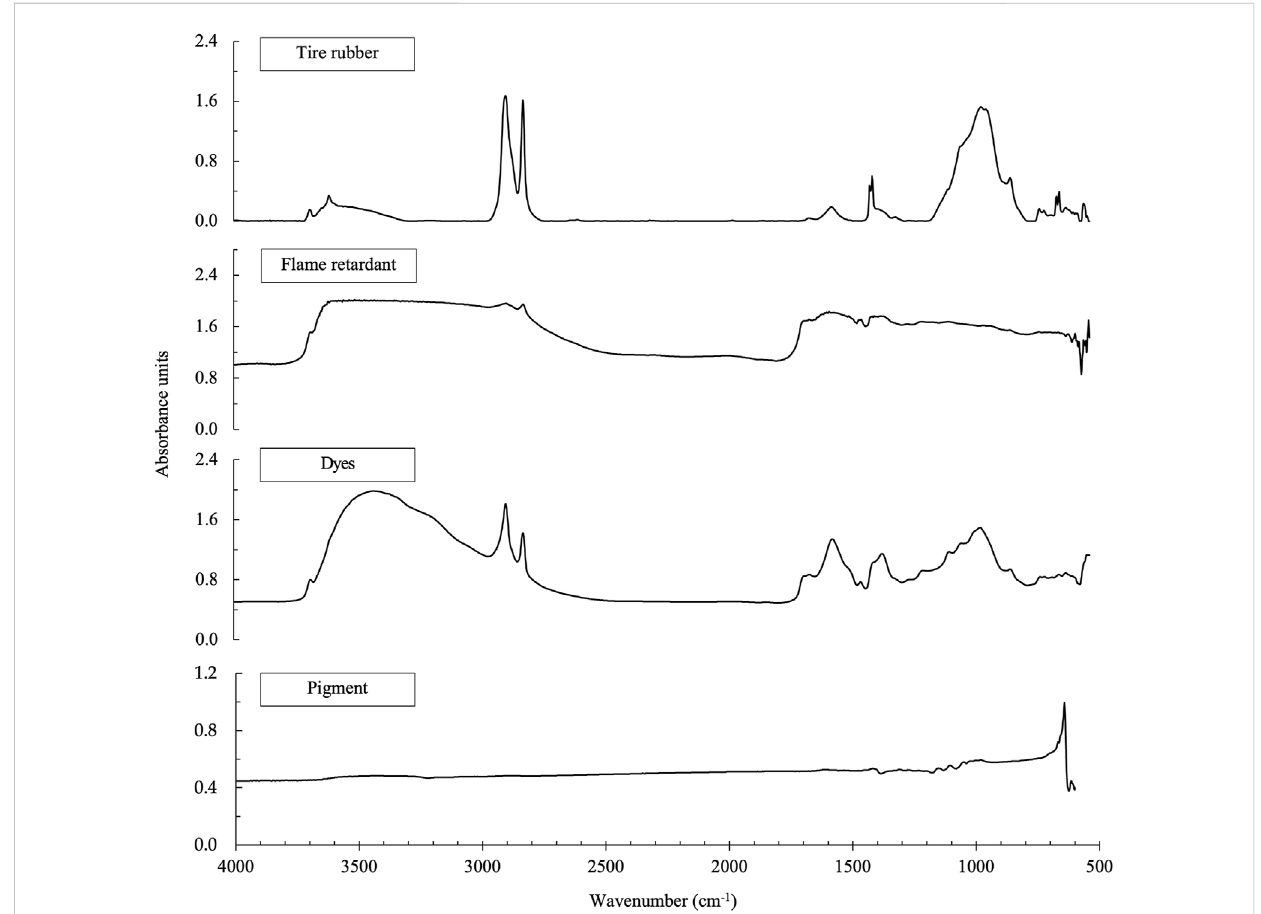
FIGURE 8 FTIRspectrashowingtypes ofmicromaterialsfound contaminatingthesedimentsamplefrom thisstudy (e.g., tirerubber, fl ameretardant, dyes,and